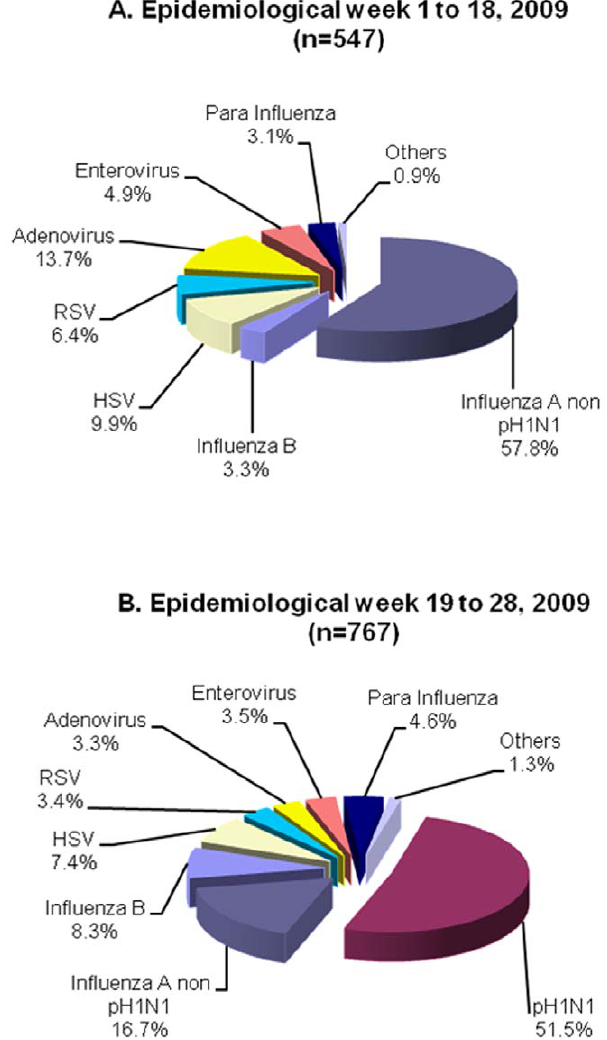
Figure 4. Viral etiology before and after the appearance of the novel pH1N1 virus in Peru. January 4 to July 13 2009. A) Before the appearance of the novel pH1N1 virus, a total of 547 positive results were obtained from 505 positive patients; co-infections were found in 42 samples. B) After the appearance of the novel pH1N1 virus, a total of 767 positive results were obtained from 730 positive patients; co- infections were found in 37 samples.